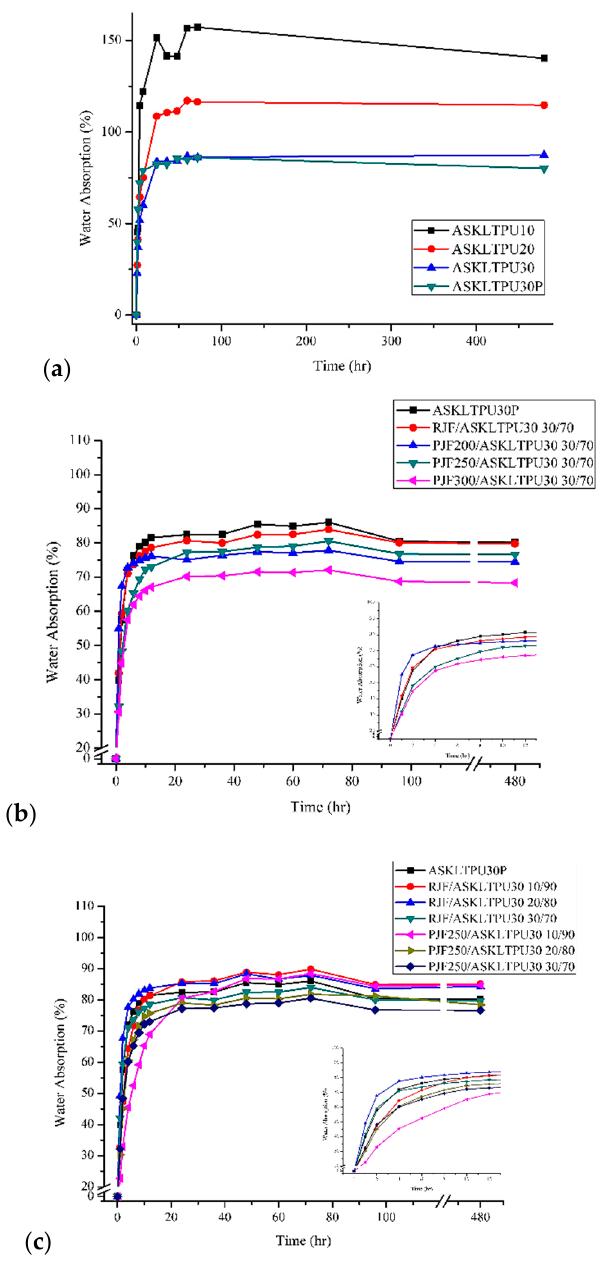
Figure 9. Water adsorption of ( a ) ASKLTPUs; ( b ) and ( c ) JF-reinforced ASKLTPU with different maximum pyrolysis temperature or different fiber content. (Inset graph: 0 – 12 h).